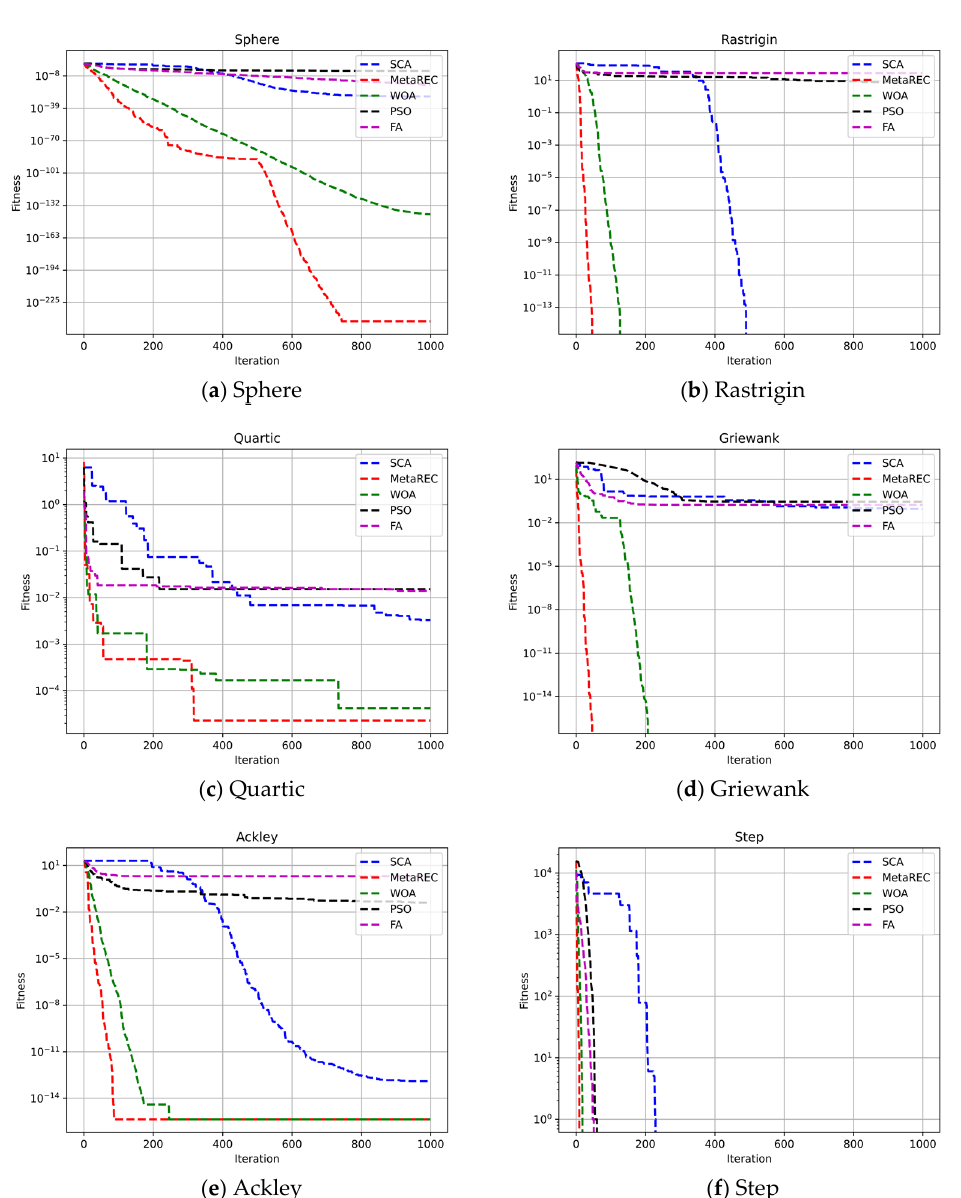
Figure 7. Comparison of the convergence of the SCA, PSO, FA, WOA, and MetaREC on test functions. ( D = 10 )